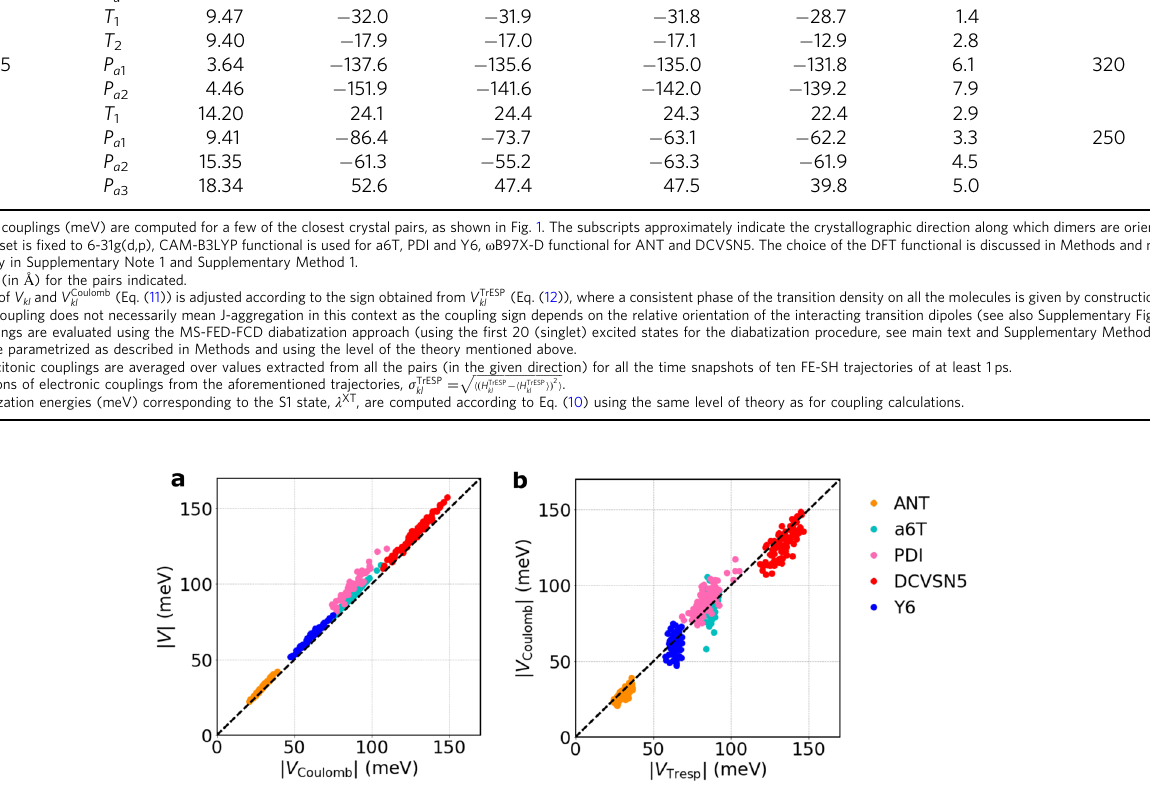
Fig. 2 Accuracy of fast excitonic coupling estimators. a Correlation between the reference total excitonic coupling V (in absolute value), obtained using MS-FED-FCD (Eq. (7) in Supplementary Method 1), and V Coulomb (Eq. (11)) for neighboring molecules along the π -stacking direction ( P b of ANT and a6T and P a , P a 1 , P a 2 for PDI, DCVSN5, and Y6 respectively). Excitonic couplings were calculated for con fi gurations taken from MD trajectories generated for supercells of the crystals at 300 K. V , couplings correspond to the off-diagonal block H 000 in MS-FED-FCD related to the lowest localized excited XT1 ; XT2 states in molecules k and l , respectively and the diabatization was performed using the fi rst 20 adiabatic states, which proved to be suf fi cient for convergence (see Supplementary Note 3). b Correlation between V Coulomb (Eq. (11)) and V TrESP (Eq. (12)). Mean relative unsigned error (%) is de fi ned as MRUE = ( ∑ n ( ∣ y calc − y ref ∣ / y ref ))/ n . In both panels the MRUE is ca. 7%. This small deviation found for the systems investigated justi fi es the use of V TrESP in FE-SH